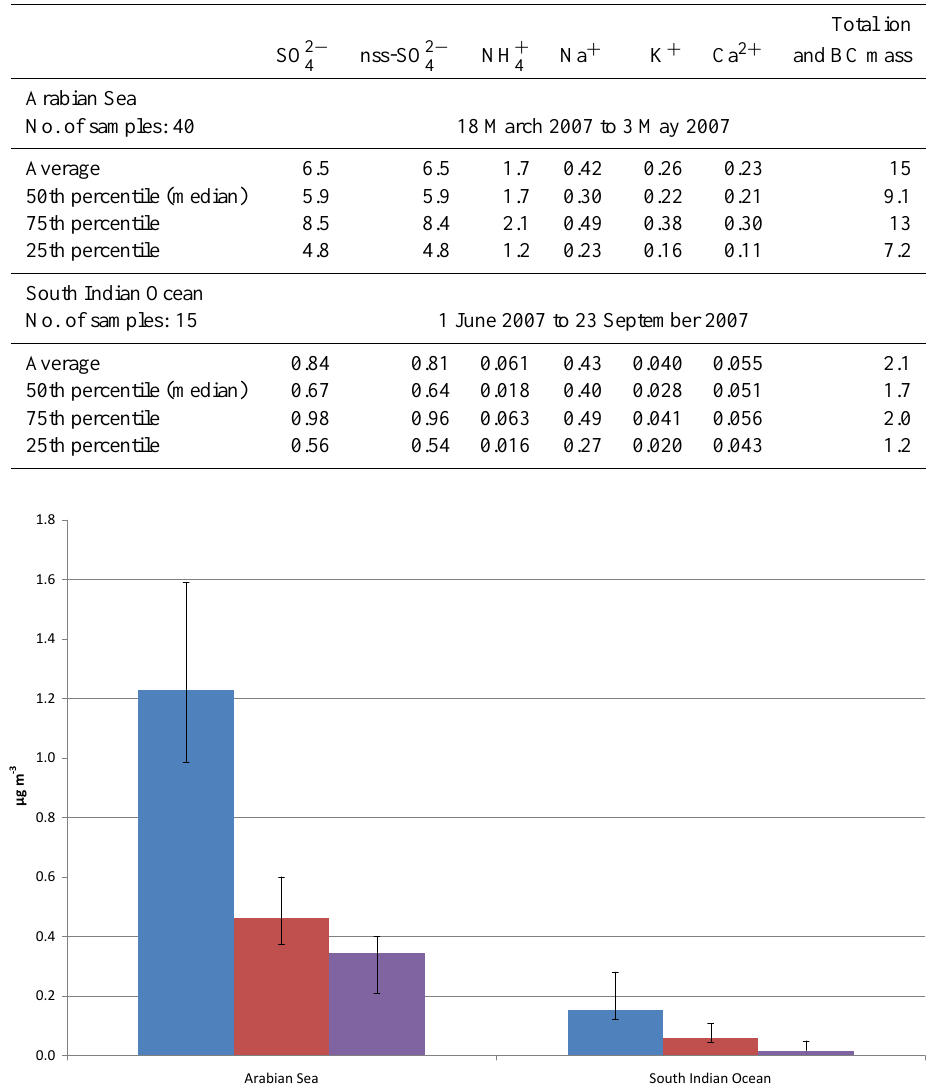
Table 3. Samples collected at MCOH during the two data selections. Data shown are ion mass concentrations and the sum of ion mass and BC mass derived using the chemical correction protocol. Units are µgm − 3 . BC mass concentrations were derived using a mass absorption cross-section of 10 ± 1m 2 g − 1 .